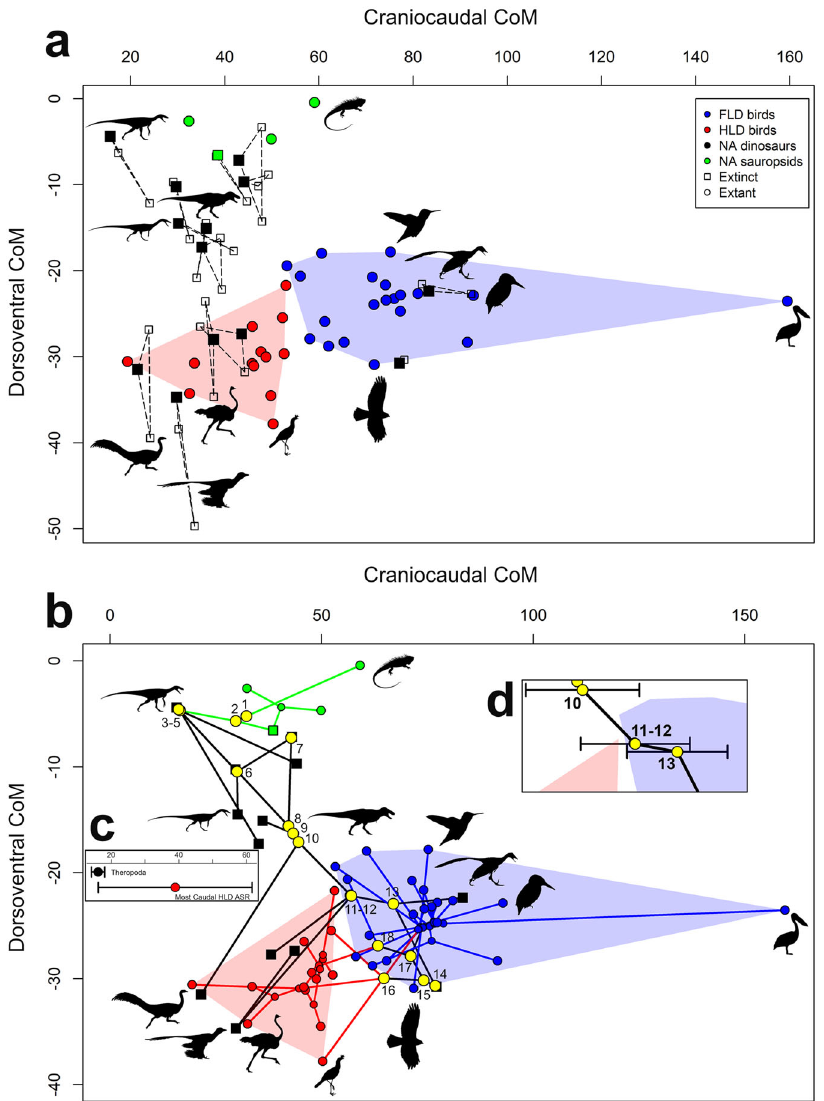
Fig. 2 | Centre-of-mass evolution in bird-line archosaurs. a Individual taxon normalised CoM positions (distance cranial and ventral to hip/body mass 0.33 ) measured in extant birds and non-avian sauropsids, and predicted positions in extinct archosaurs based on skeleton:skin volume ratios and allometric equations from extant taxa. b CoM phylomorphospace plot of the 50 studied taxa, with extinct taxa represented as squares, and extant taxa (and surviving nodes) as cir- cles. The larger yellow circles represent the major reconstructed nodes through avian evolution, and are numbered as followed, 1. Sauropsida, 2. Archosauria, 3. Dinosauria, 4. Saurischia, 5. Theropoda, 6. Neotheropoda, 7. Dilophosaurus + Neotetanurae, 8. Neotetanurae, 9. Coelurosauria, 10. Maniraptoriformes, 11. Pen- naraptora, 12. Eumaniraptora, 13. Avialae, 14. Ornithuromorpha, 15. Neornithes, 16. Palaeognathae, 17. Neognathae, 18. Galloanserae. c Inset of the main plot ( b ) showing the overlapping CC_CoM con fi dent intervals of the Theropoda node and